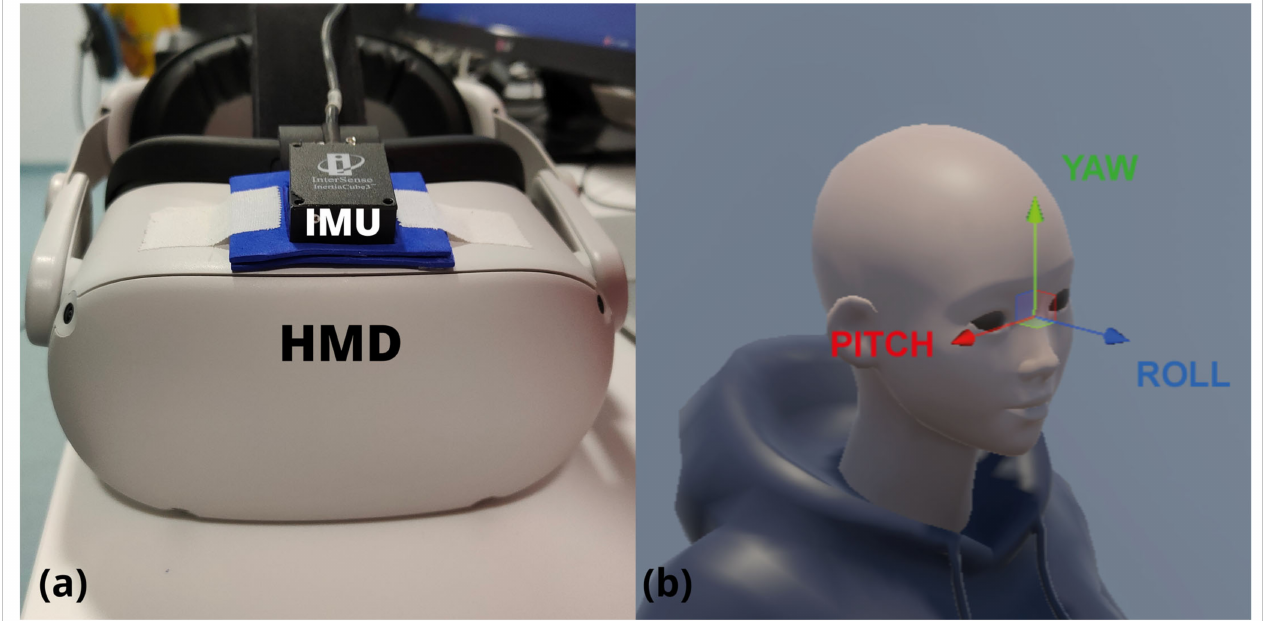
Figure 1. ( a ) Inertial measurement unit (IMU) placed over the head-mounted display (HMD); ( b ) coordinate reference system of the device in a test